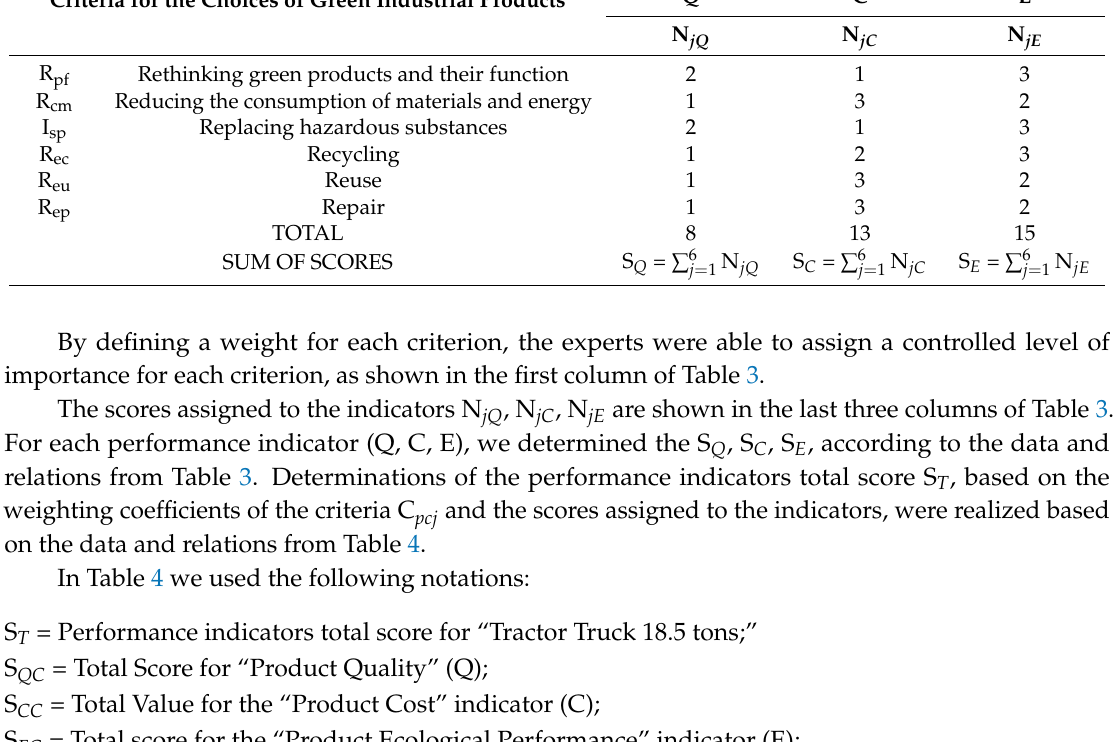
Criteria for the Choices of Green Industrial